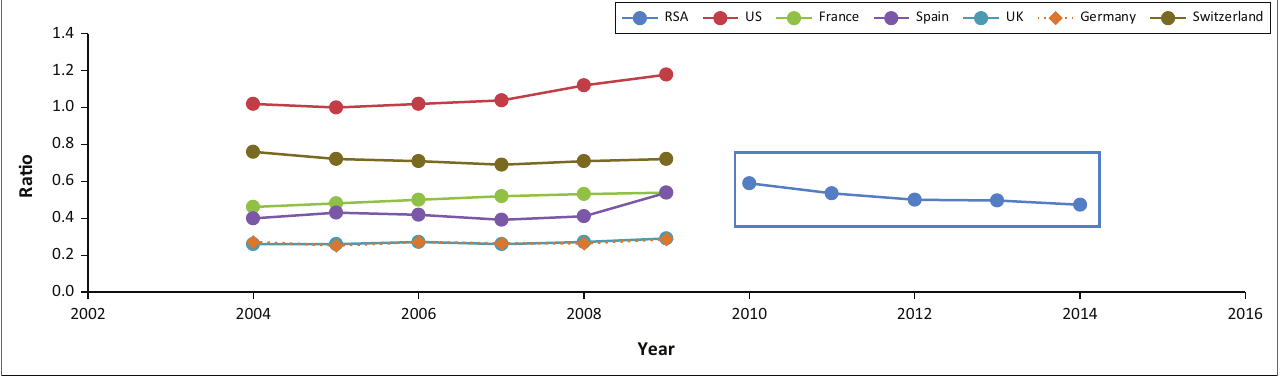
FIGURE 2: Expenditure to income ratio for selected